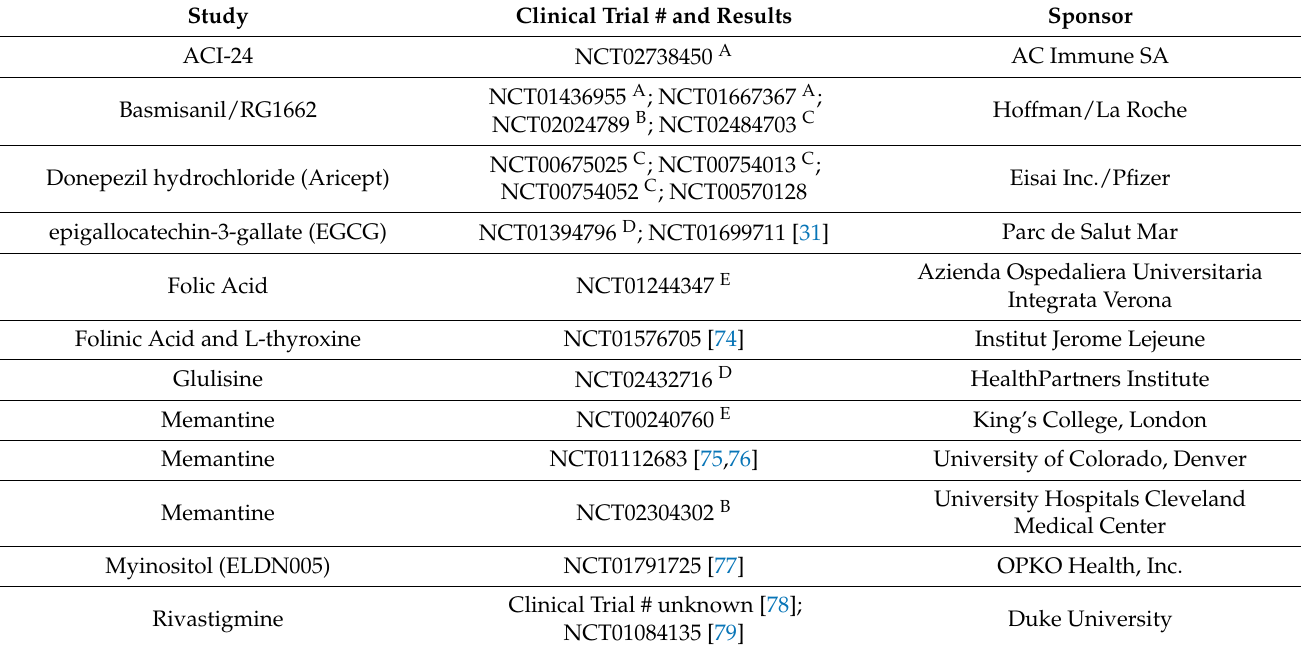
Table 2. Clinical Trials in the US and Europe. A = Completed, phase 1, no results posted; B = Completed, phase 2, no results posted; C =Terminated, efficacy standard not met; D = Completed, phase 2, results posted, not publicly available; E = Unknown status, no results posted; F = Completed, no phase listed, no results